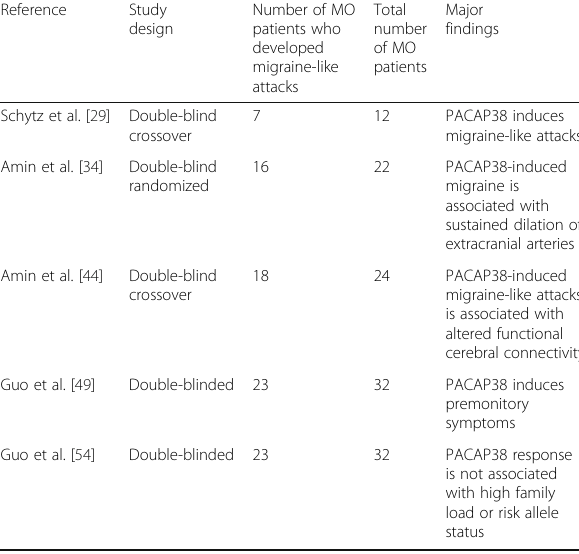
Table 1 Overview of PACAP38 provocation studies in migraine without aura (MO) patients Reference